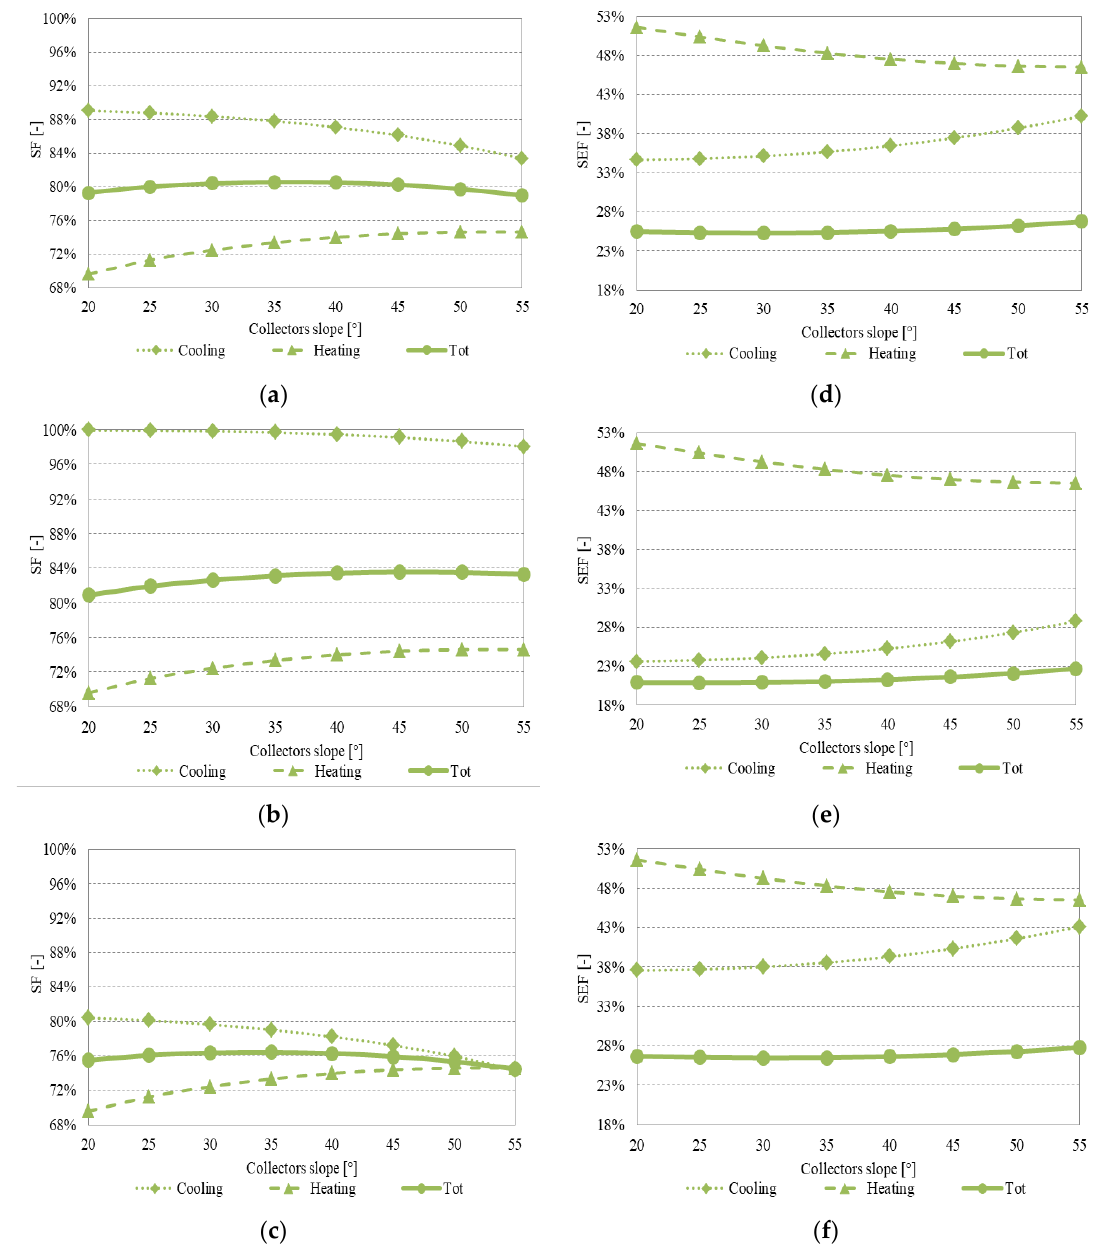
Figure 6. Solar fraction (left side) and solar energy factor (right side) as a function of the tilt angle in cooling operation, heating operation and total, for the plant with 34 m 2 of solar collectors and the innovative AHU equipped with: ( a , d ) silica-gel DW, ( b , e ) MILGO DW and ( c , f ) zeolite-rich tuff DW.